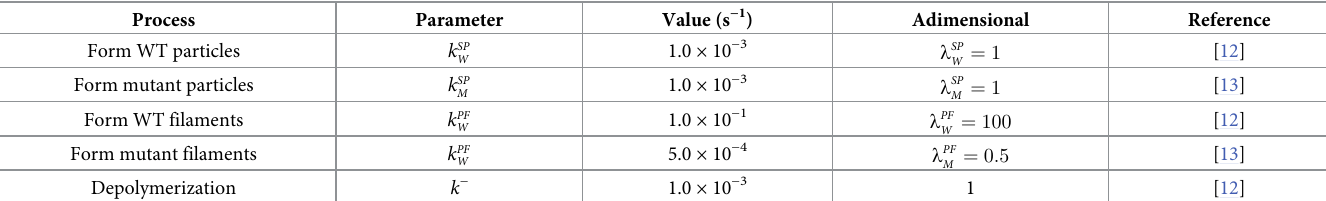
Table 1. Parameters used in the mathematical models (see also S1